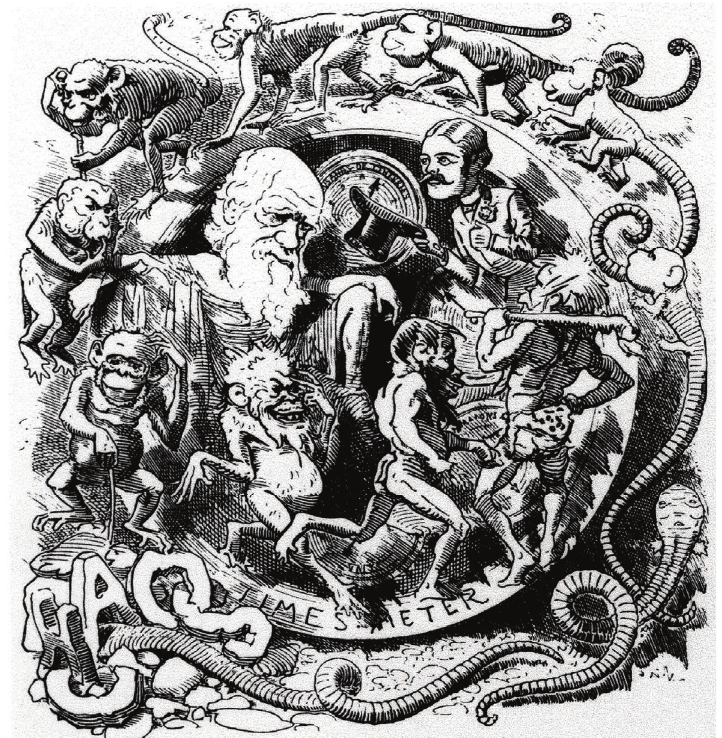
Figure 9: Cartoon by E. L. Sambourne, published in the Punch in 1882 with the sentence “Man is but a worm”. This parody of Charles Darwin’s concepts on the origin of humanity has been corroborated by recent molecular data on the phylogenetic relationships of annelids and vertebrates (adapted from